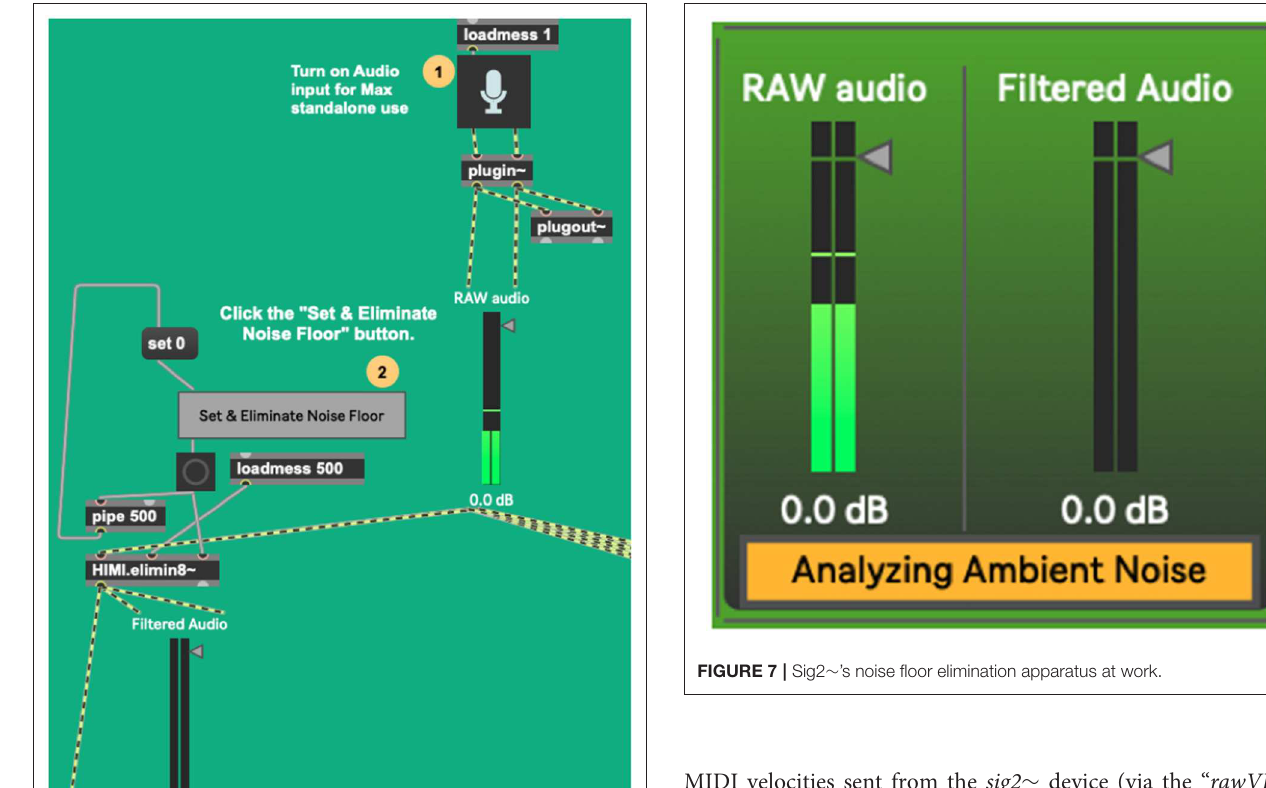
MIDI velocities sent from the sig2 ∼ device (via the “ rawVEL ” message) and defines dynamic ranges either derived from